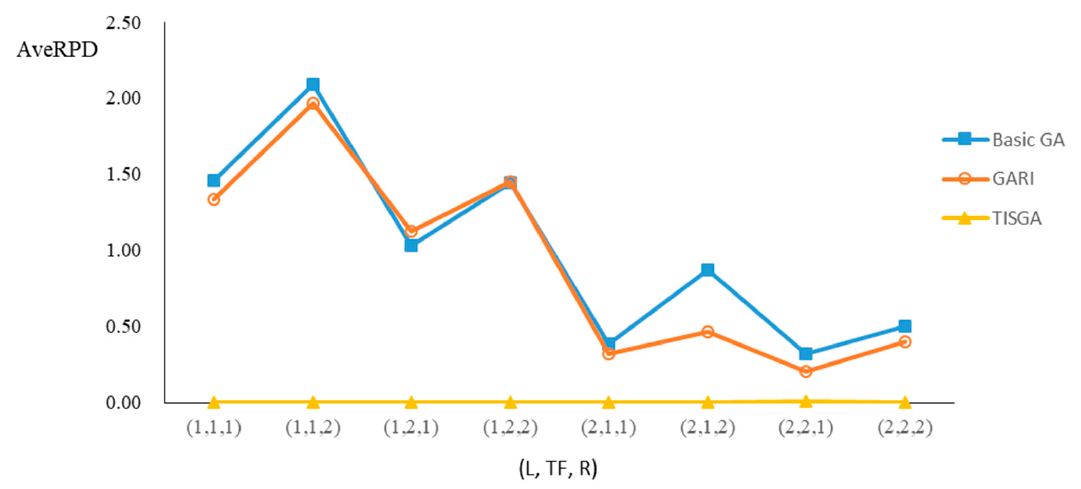
Figure 11. Comparison results for n = 35 with eight combinations of (L, TF, R).